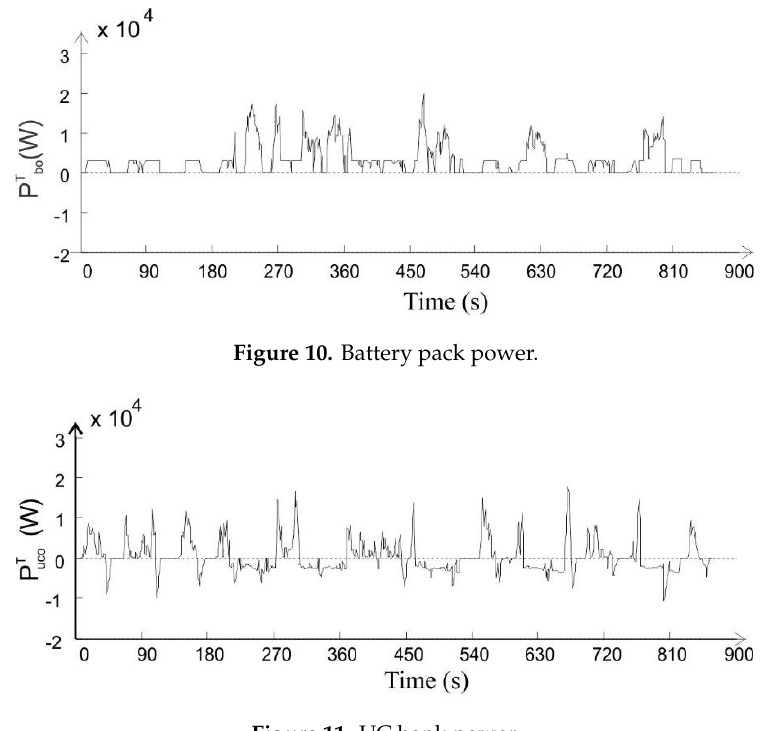
Figure 9. Vehicle load power profile.